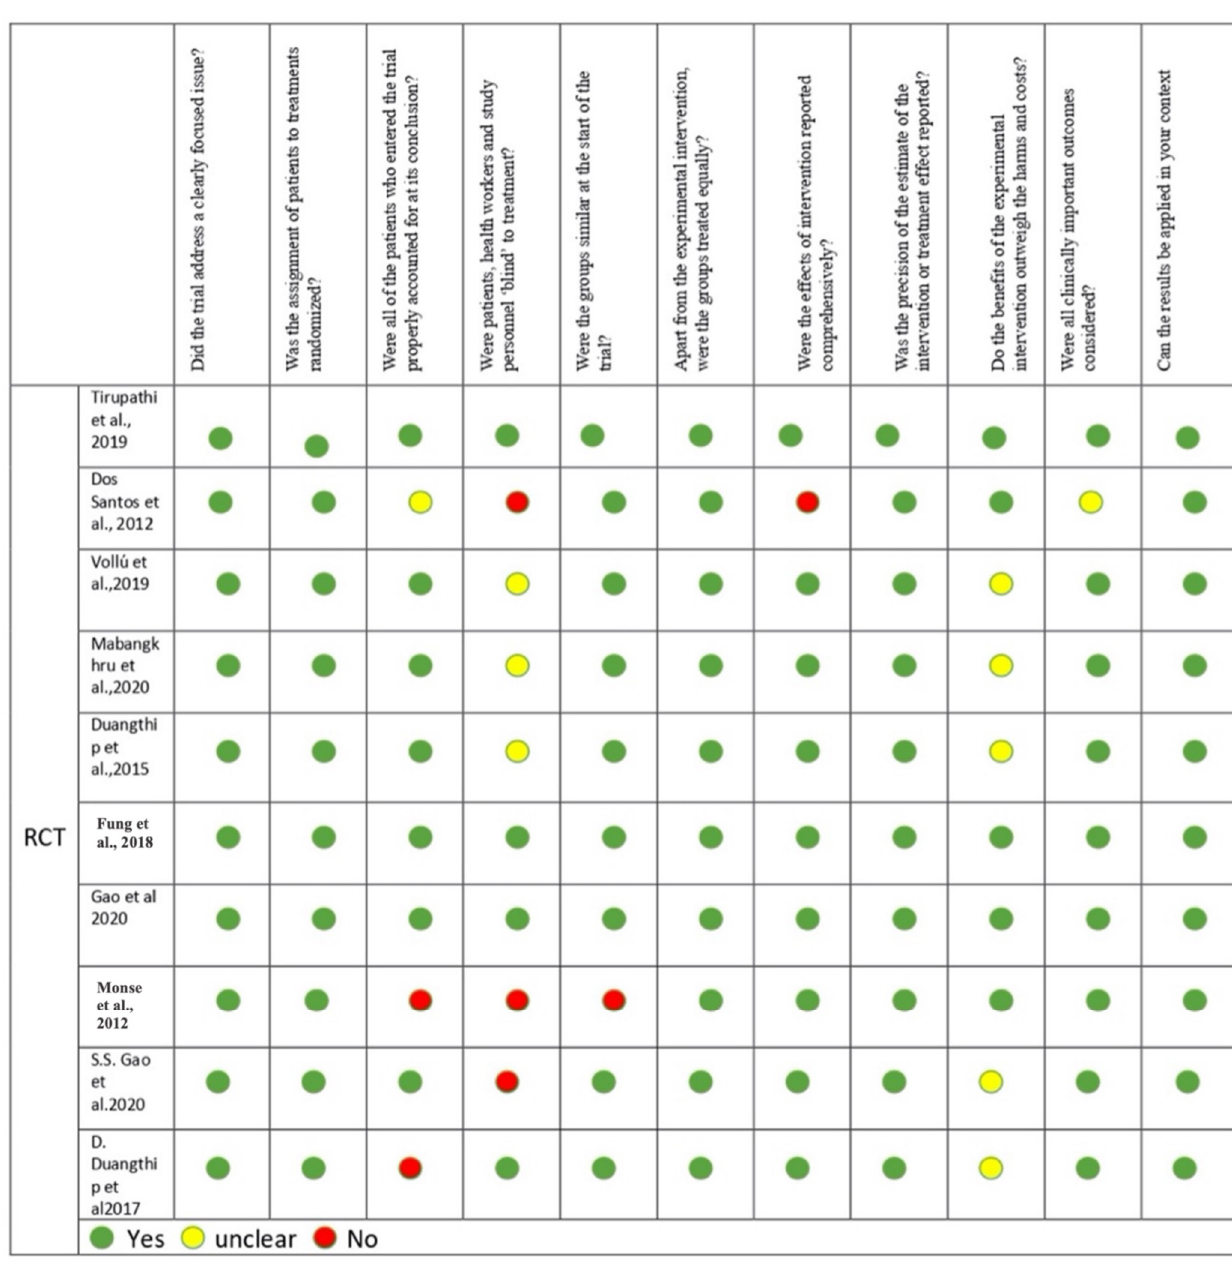
Figure 2. Quality assessment of the included studies by CASP tool